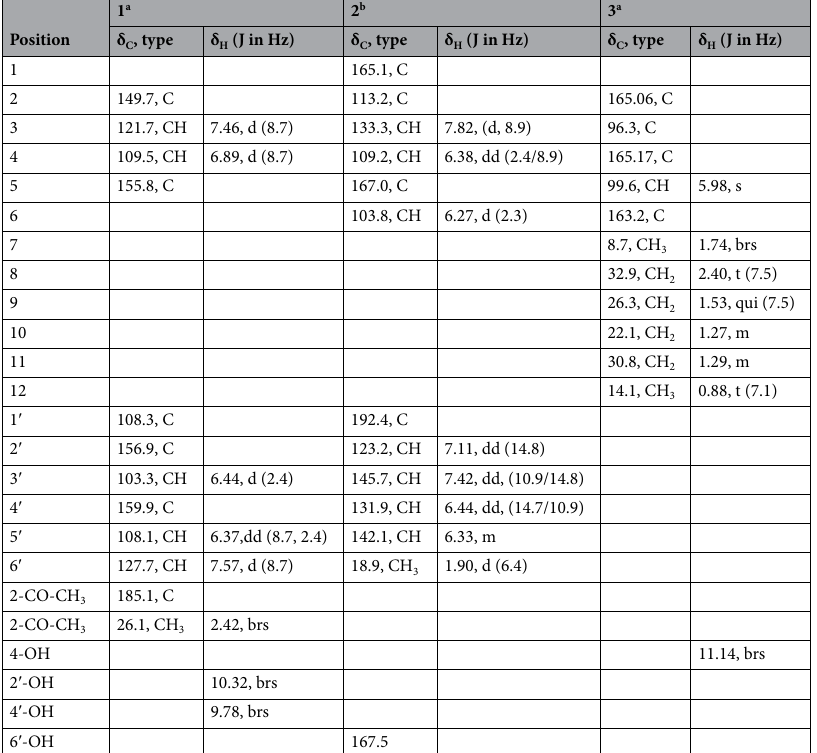
Table 3. 1 H (500.13 MHz) and 13 C NMR (125.76 MHz) data of Compounds 1–3. a Data obtained in DMSO- d 6. b Data obtained in MeOD.